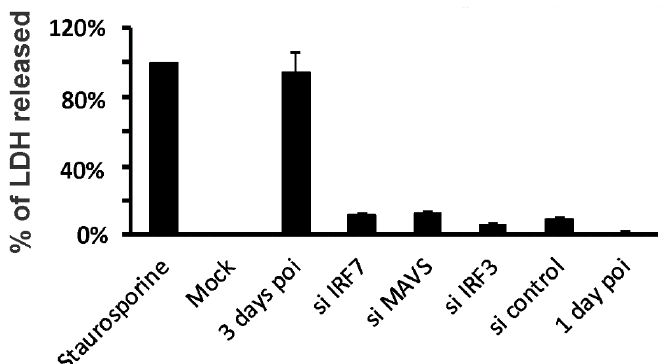
Figure 4. E ff ects of siRNA treatment and IAV infection on cell viability. BCi-NS1.1 were incubated with siRNA for 3 days. For IAV PR8 infected cells, BCi-NS1.1 were incubated with IAV (MOI = 0.2) for 1 or 3 days. Staurosporine (10 µ M) treated cells were used as a positive control for cytotoxicity. LDH activity of the supernatant was measured by using the LDH-Cytotoxicity Assay Kit. Cytotoxicity is expressed as the percentage of supernatant released LDH to LDH released from Staurosporine treated cells. Results are shown as the Mean ± SEM from three separate experiments.